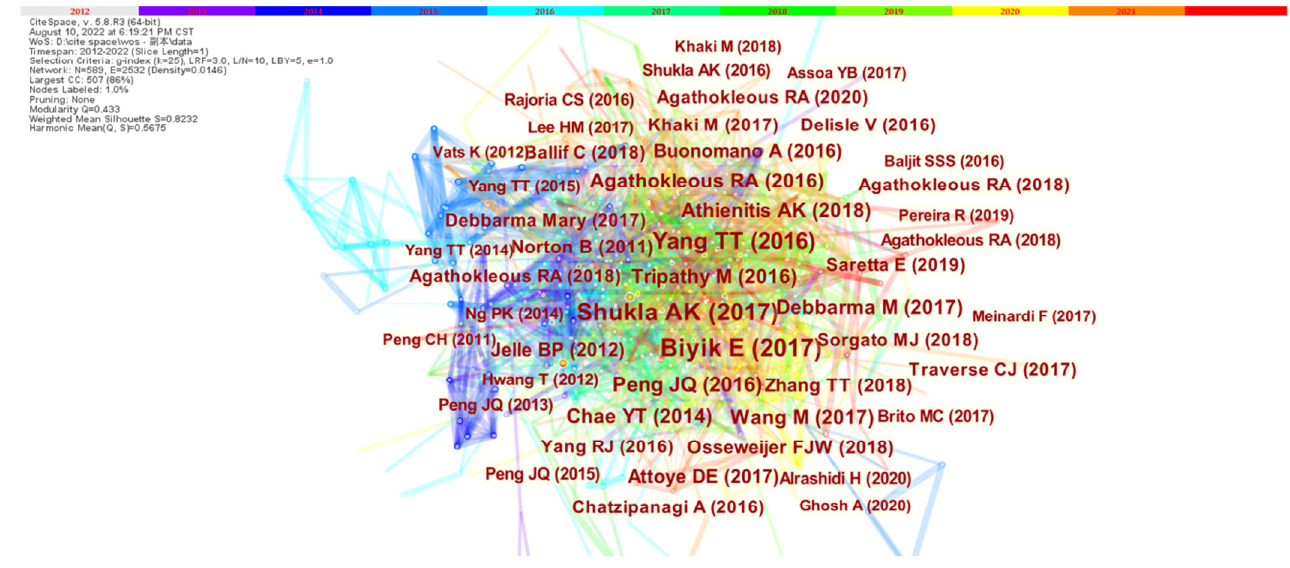
Figure 8. Co ‐ citations and co ‐ occurrences of documents. Figure 8. Co-citations and co-occurrences of